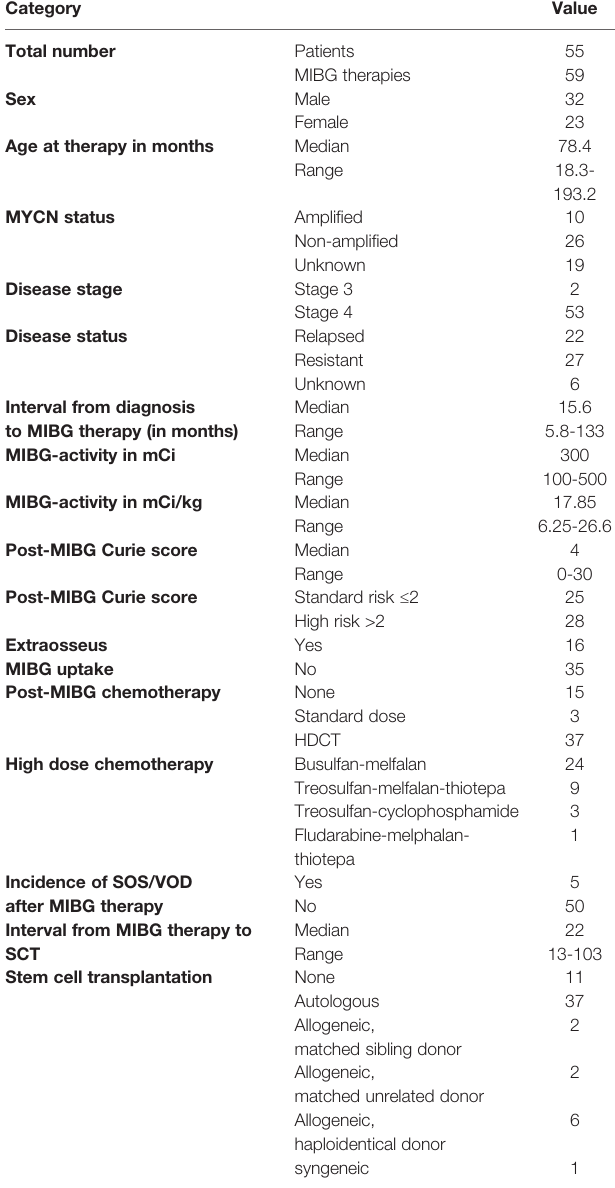
TABLE 1 | Patient